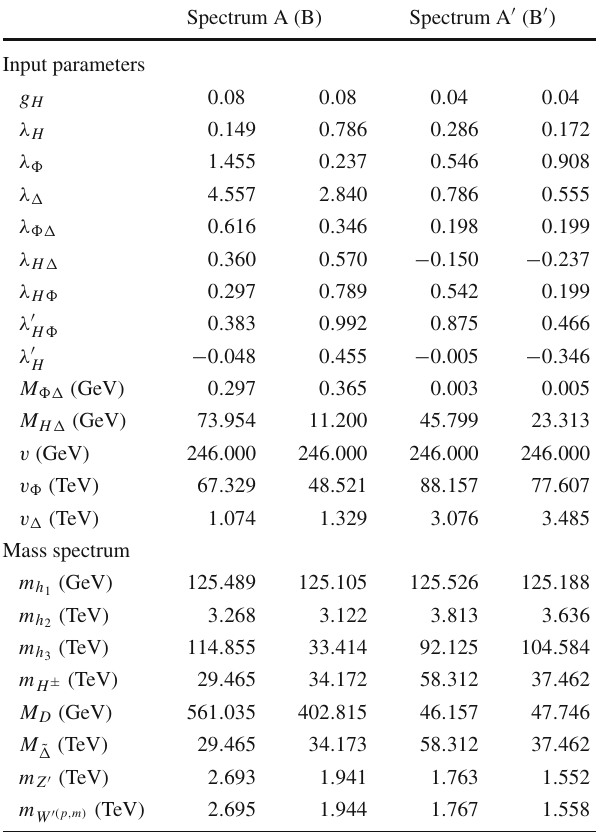
Table 7 Four benchmark points in the parameter space for the four mass spectra of interest in this work Spectrum A (B) Spectrum A (cid:2) (B (cid:2)